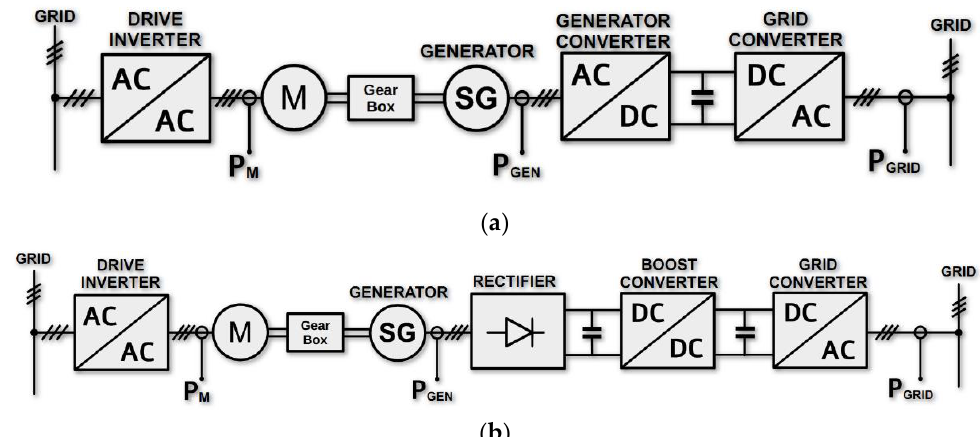
Figure 4. Energy conversion system with a generator converter: ( a ) topology T1 and ( b ) topology T2 and the method of power measurement in both systems.